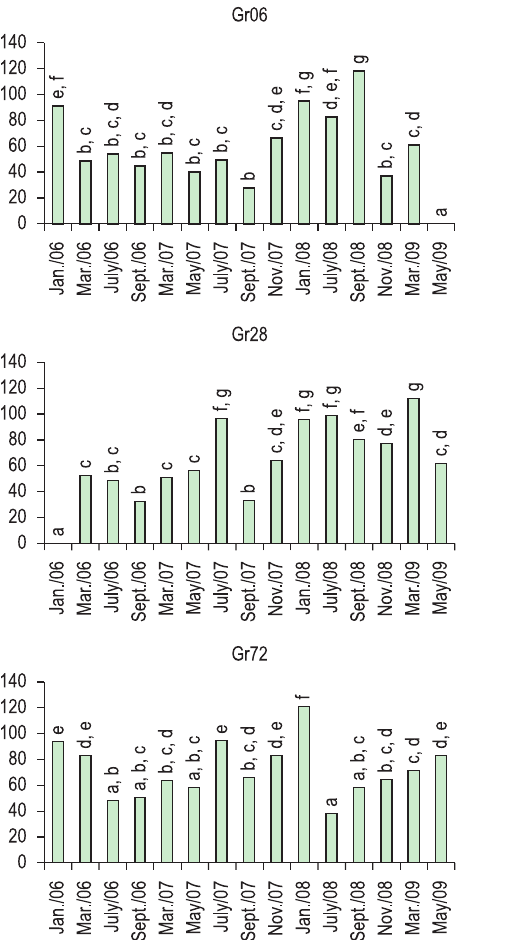
Figure 5. Comparison of births at each point during the period sampled, applying the Duncan Test. Months with the same letter were not significantly different according to the LSD test (p ≤